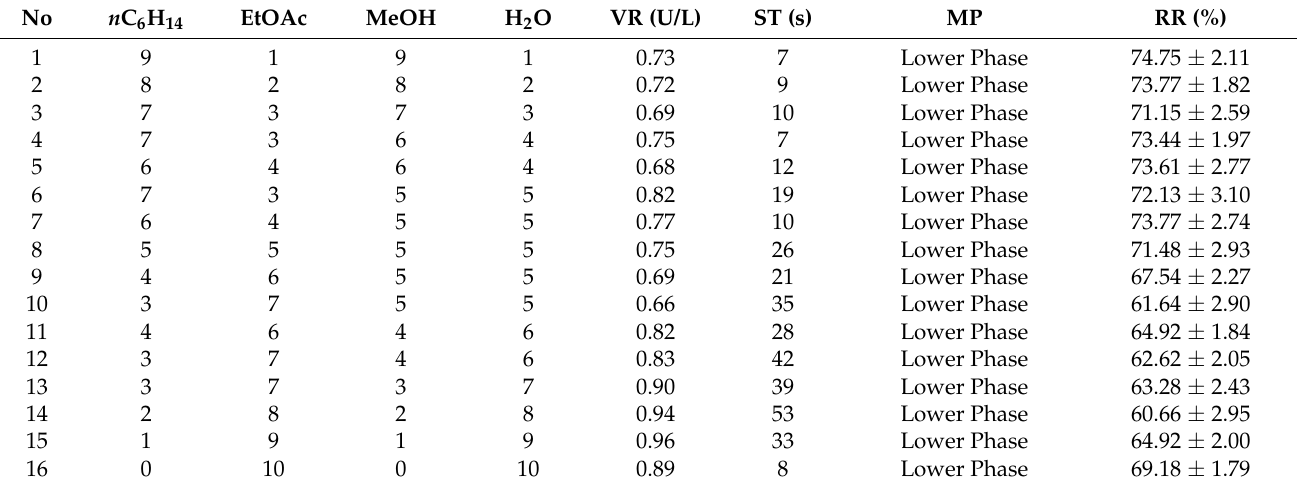
Table 2. The retention rate of GUESS-based n -hexane–ethylacetate–methanol–water solvent